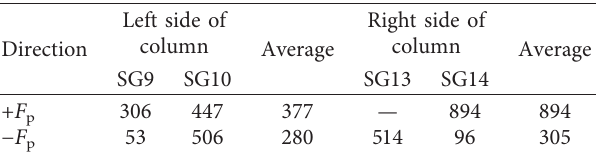
Table 11: Transverse strain of type-I sleeve in YZ2 at the peak state ( με ).